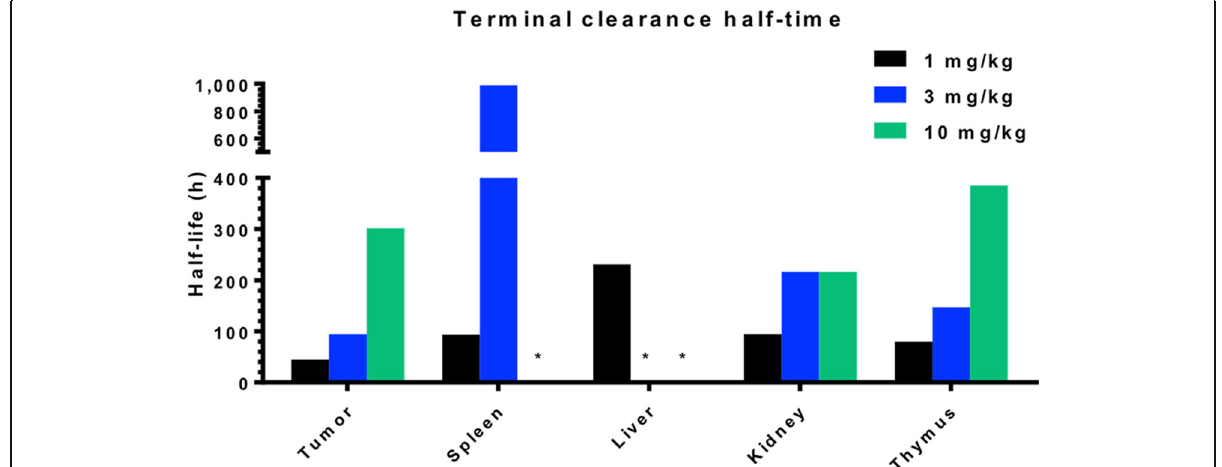
Fig. 2 Terminal clearance half-time, calculated from last two measured time points